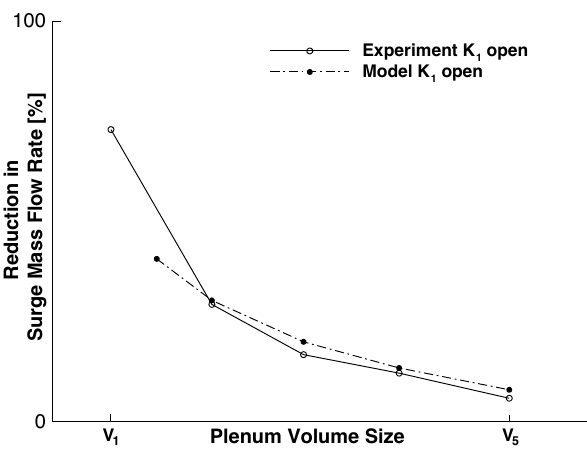
Figure 6. Shift in surge mass flow rate for plenum volume variation.